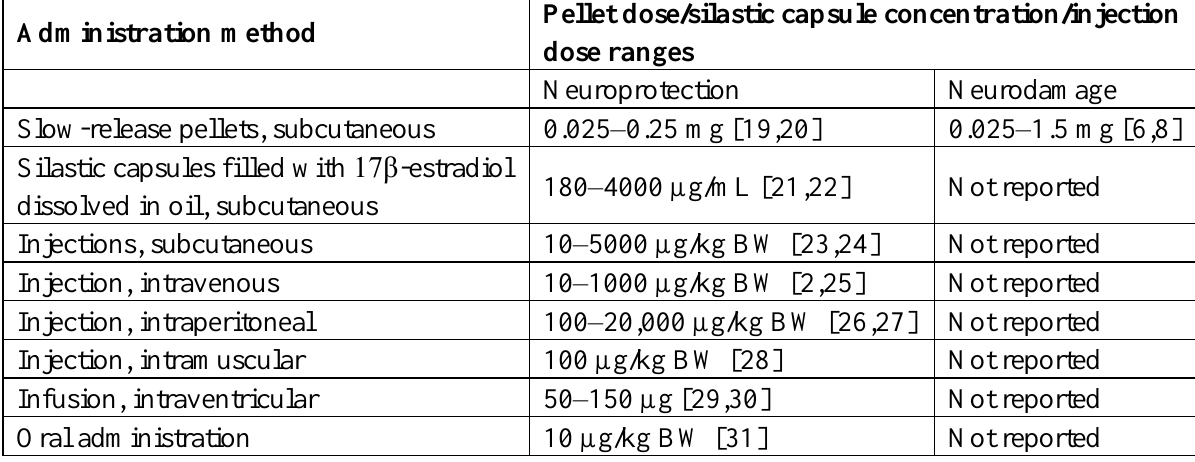
Table 1. Administration method dose ranges in relation to neuroprotection and neurodamage. 17β-estradiol doses and capsule concentration ranges reported to induce neuroprotection and neurodamage, respectively, in rat models of cerebral ischemia. For injection regimens, daily doses are presented. Silastic capsules containing crystallized estrogen are omitted from the table, but were consistently neuroprotective